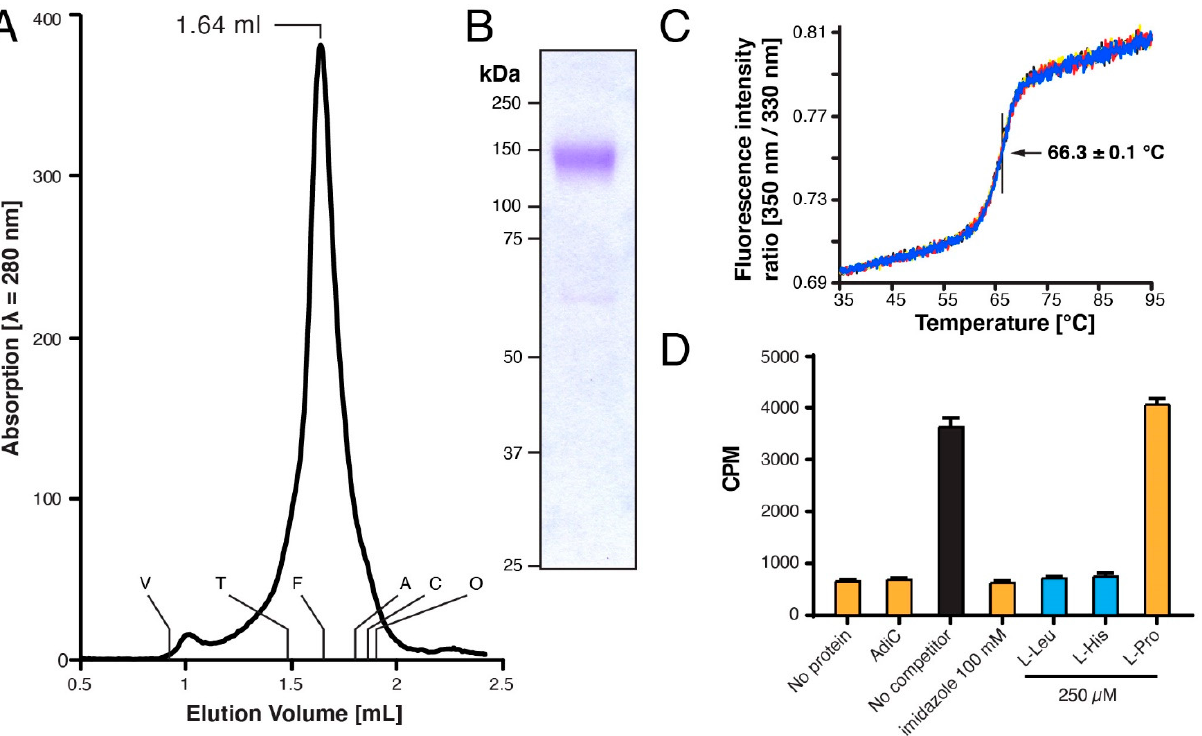
Figure 3. Characterization of purified human 4F2hc-LAT1 heterodimer. ( A ) Size exclusion chromatographic (SEC) elution profile of purified 4F2hc-LAT1 ( ≈ 50 µg injected) eluted with SEC buffer. A prominent monodisperse elution peak was detected at 1.64 mL. The void (V) and retention volumes are indicated for the following standard proteins: thyroglobulin (T, 669 kDa), ferritin (F, 440 kDa), aldolase (A, 158 kDa), conalbumin (C, 75 kDa), and ovalbumin (O, 43 kDa). ( B ) Coomassie Brilliant Blue-stained 10% SDS-PAGE gel of the SEC-peak fraction (1.5 µg of protein loaded). ( C ) Thermograms of the GDN-purified 4F2hc-LAT1 (1 µM) are displayed, and the T i of 66.3 ± 0.1 °C indicated. Data are represented as mean ± SD from a quadruplicate (individual thermograms are depicted in blue, black, yellow, and red). ( D ) Scintillation proximity assay (SPA) of 4F2hc-LAT1 with the substrate [ 3 H]L-leucine. Various experiments are shown, i.e., a total signal experiment (black), four negative controls (orange), and experiments using good 4F2hc-LAT1 substrates such as L-Leu and L-His (blue). Displayed is one representative experiment (of three) and counts per minute (CPM) are given with SD from technical triplicates.